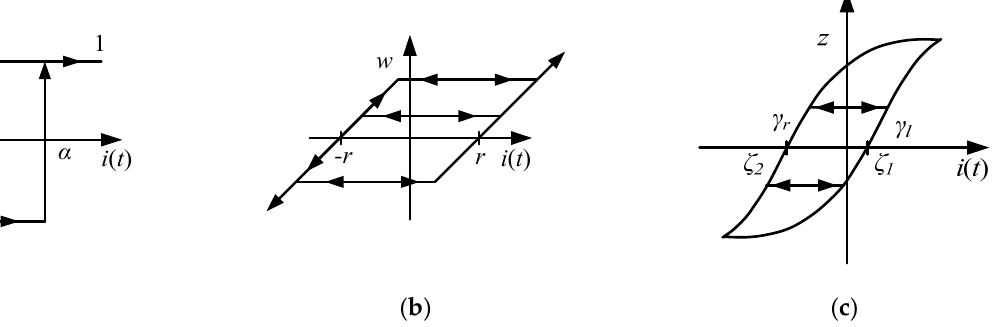
Figure 9. Preisach relay operator ( a ), classical play operator from PIM ( b ) and generalised play operator from GPIM ( c ) for input i ( t ).